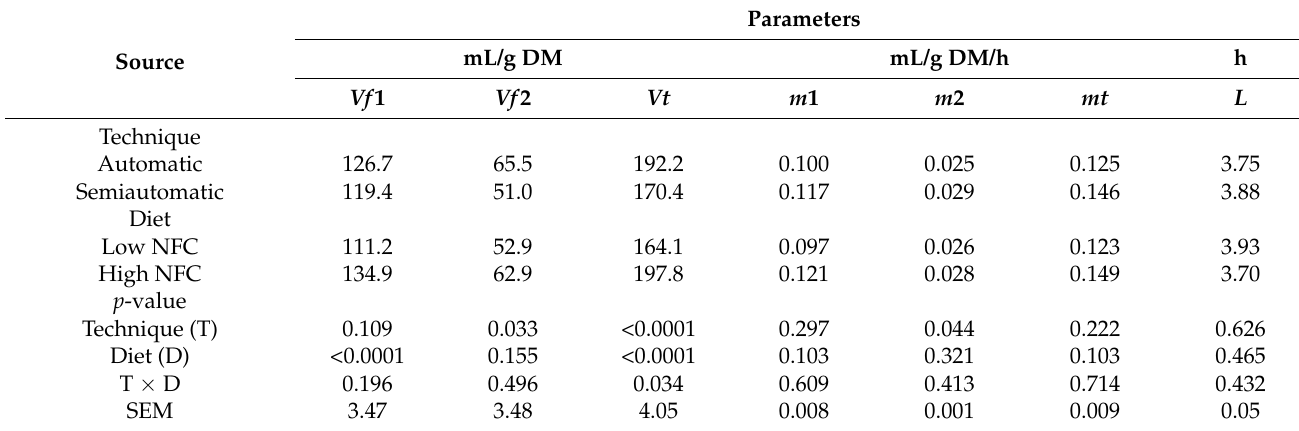
Table 2. In vitro gas production parameters of two diets as a function of two gas production mea- surement techniques after 72 h of incubation and “diet × technique” interactions for total gas production ( Vt ).